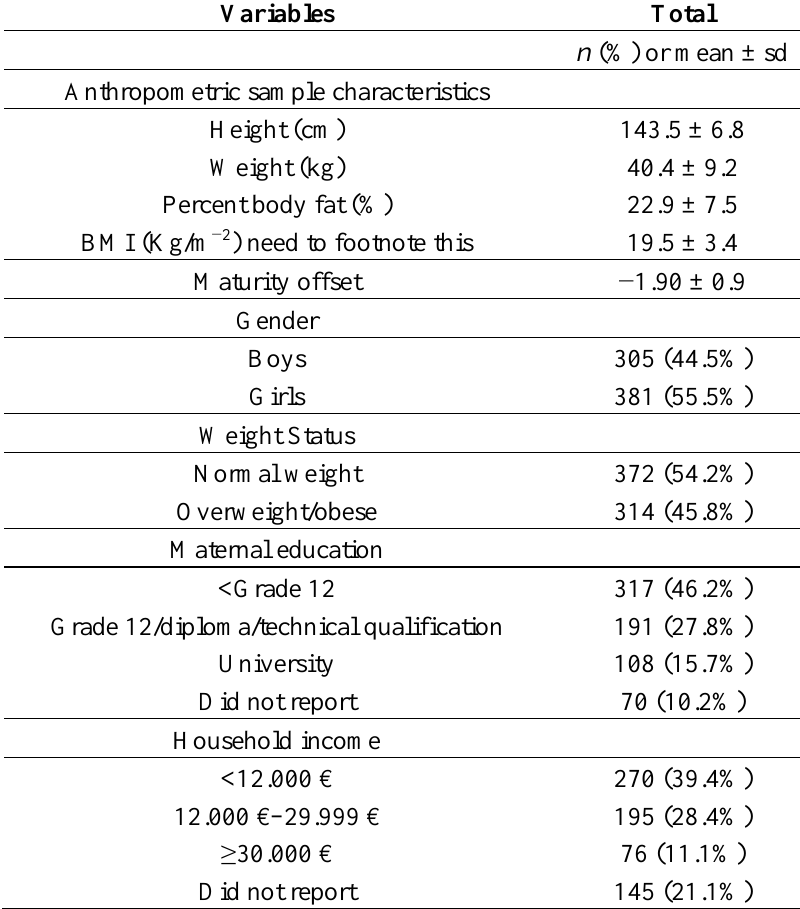
Table 1. Sample descriptive